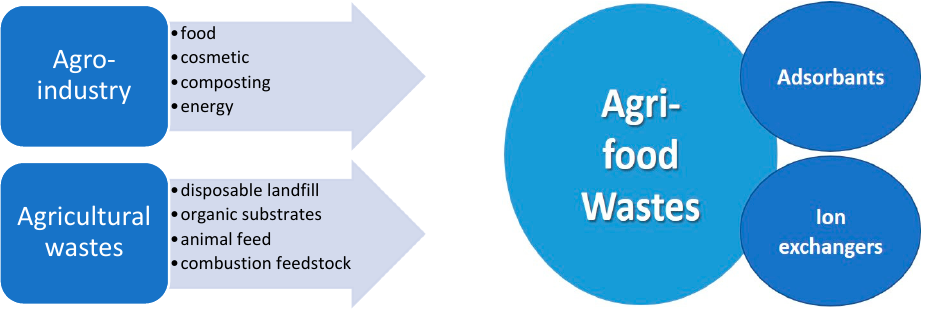
Figure 1. The main sources of agri-food wastes and their applications.